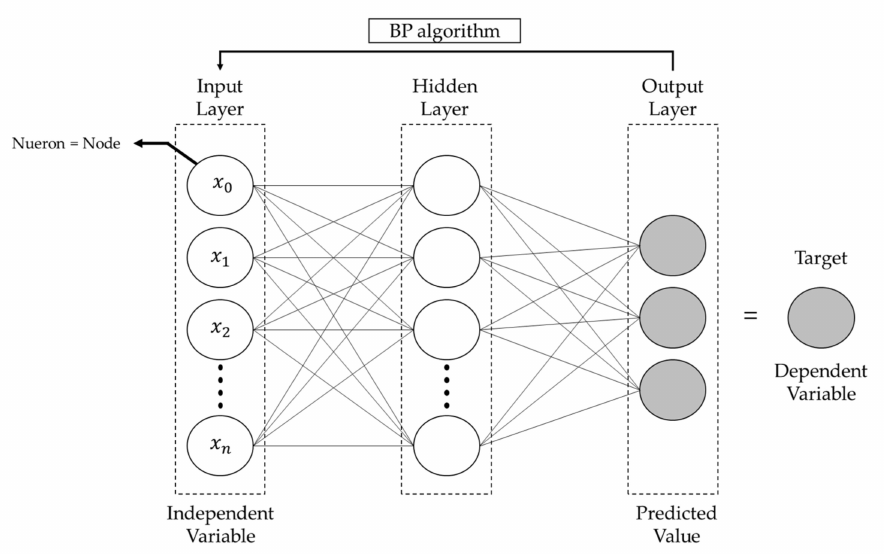
Figure 1. Structure of an artificial neural